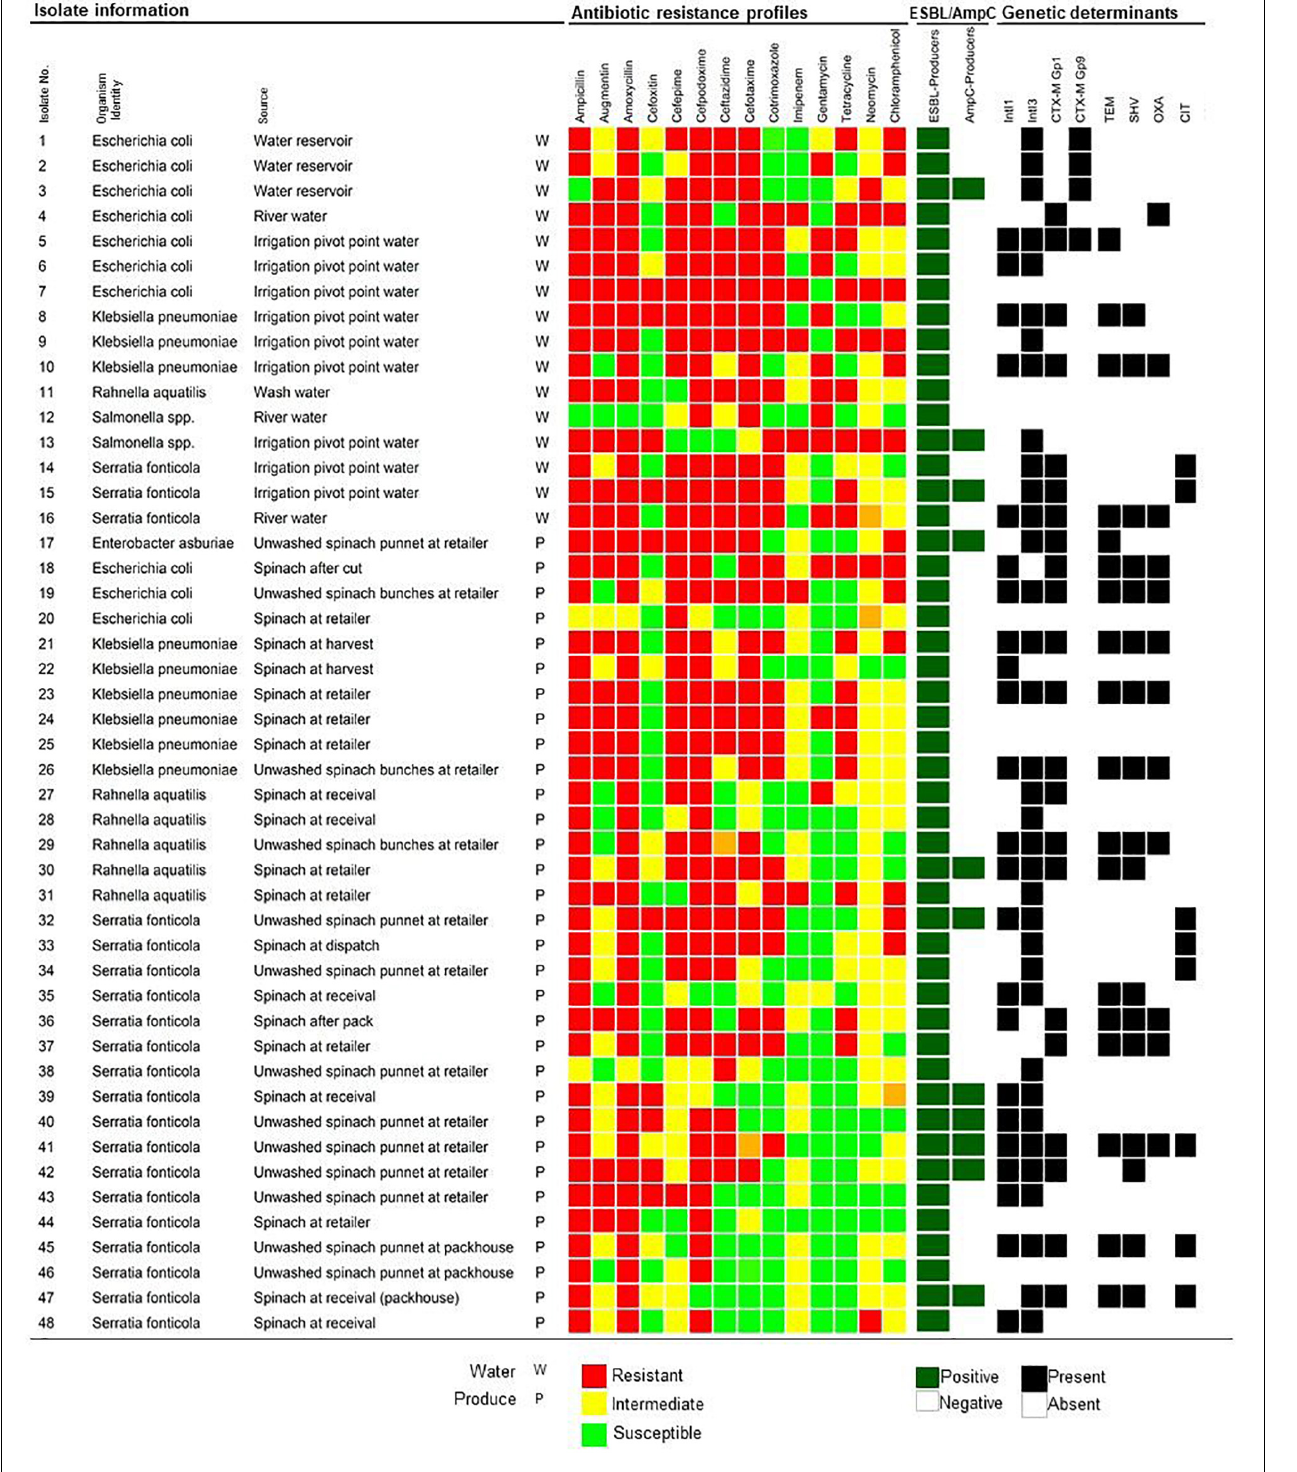
Frontiers in Microbiology |